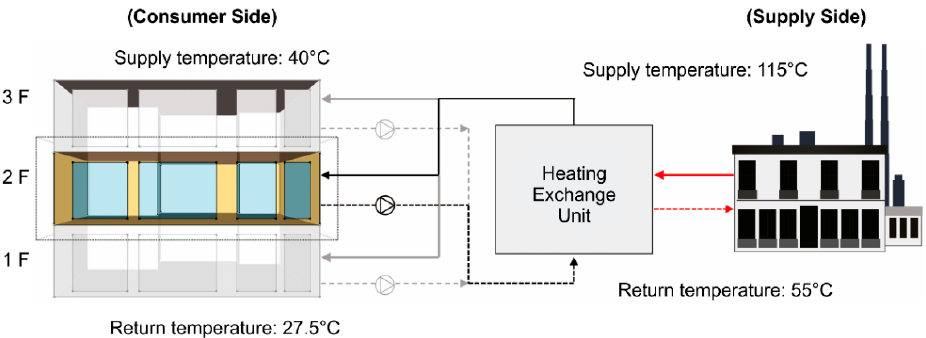
Figure 7. Conception of hot-water circulation between the district heating and an apartment building.